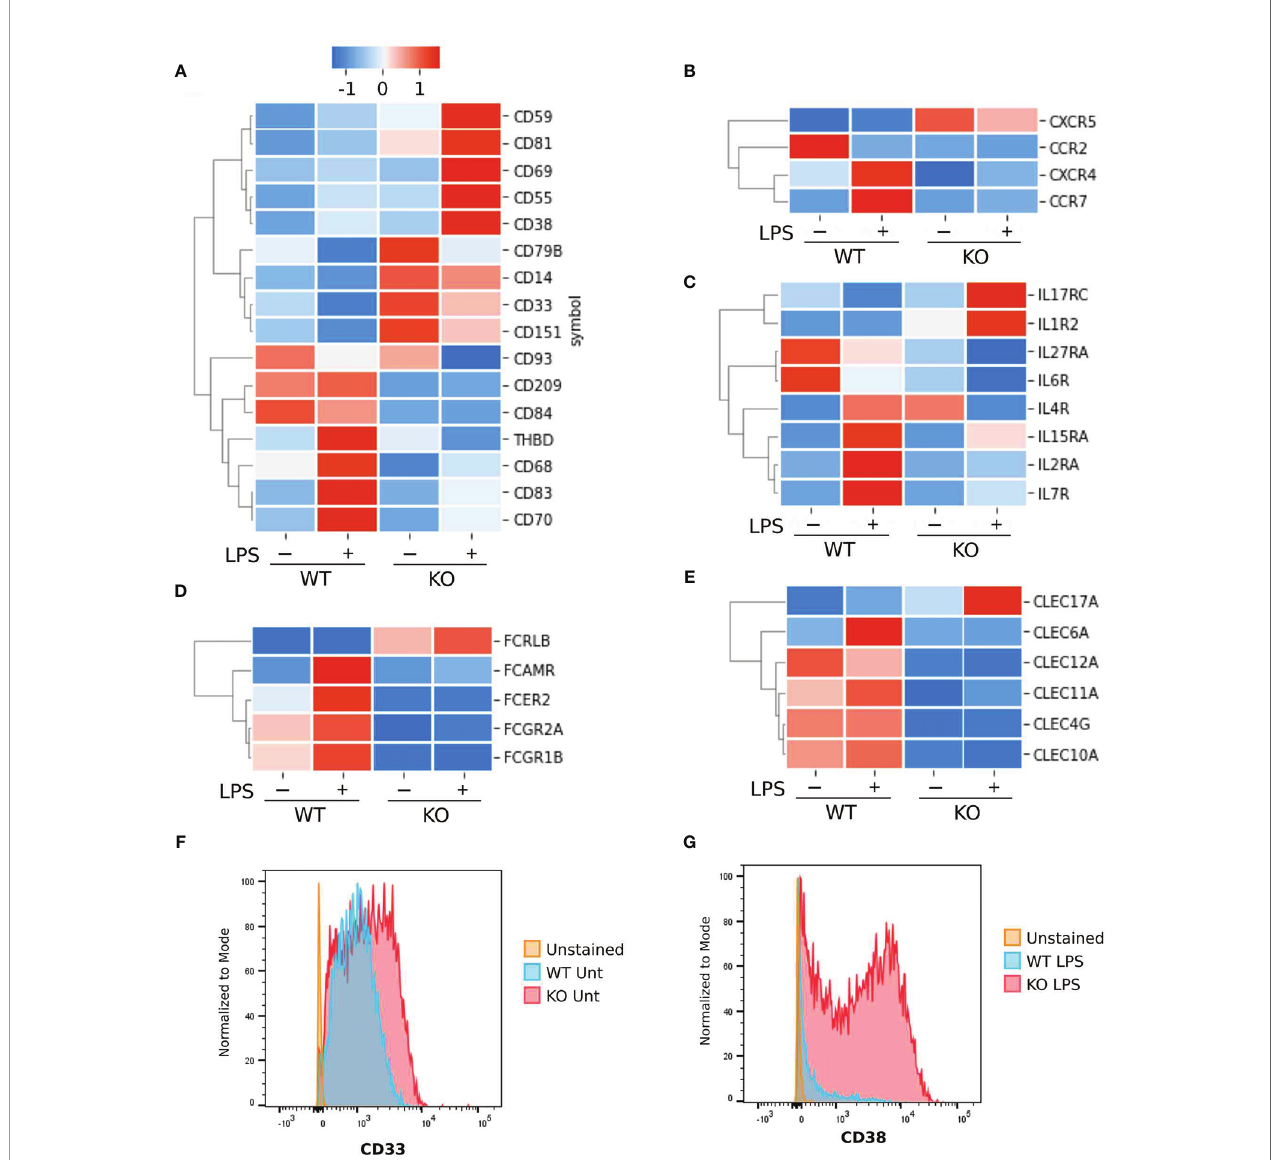
FIGURE 6 | Surface markers differentially expressed between NFKB1 -/- and wild type THP1 cells. Heatmaps Z-score normalized showing gene expressions as the average of replicates. (A) Cluster differentiation markers. (B) Chemokine and cytokines receptors. (C) Interleukin receptors. (D) Fc receptors. (E) C-type lectin domain family members. (F) Analysis by fl ow cytometry of CD33 and (G) CD38 cell surface protein expression in untreated (unt) or LPS stimulated wild type (WT) or NFKB1 -/- (KO) THP1 cells using speci fi c